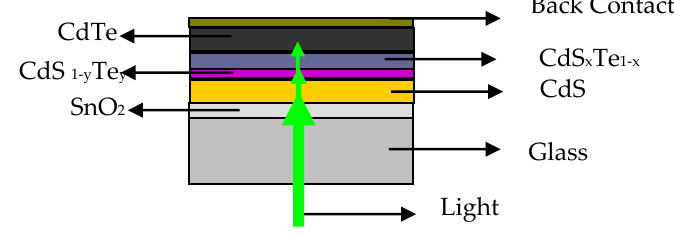
Figure 1. A schematic of the superstrate configuration of the SnO 2 /CdS/CdTe thin film solar cell, where the solid solutions on both sides are shown (drawing is not to scale).